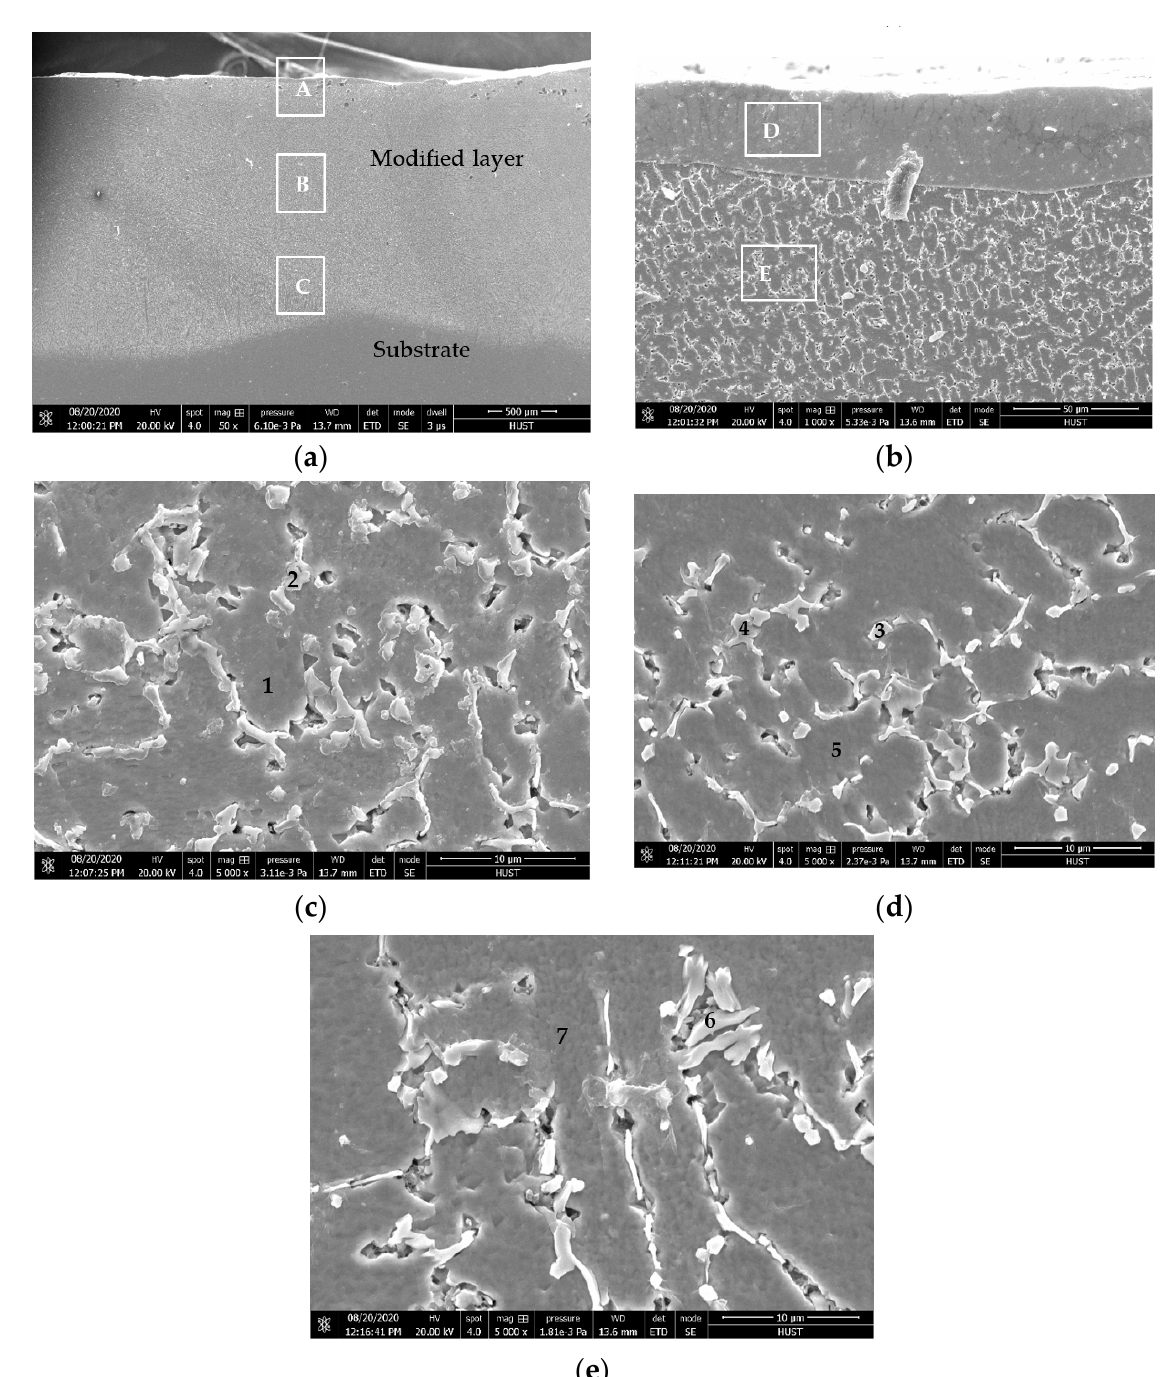
Figure 2. SEM images of the laser clad La 2 Zr 2 O 7 /NiCoCrAlY coating: ( a ) whole, ( b ) at position A, ( c ) at position E, ( d ) at position B, ( e ) at position C. (A, B and C represent the top, middle and bottom of the coating, respectively. D and E represent the locally amplified La 2 Zr 2 O 7 layer and alloying layer at position A, respectively. Numbers 1–7 represent substrates or particles at corresponding positions of the coating.).